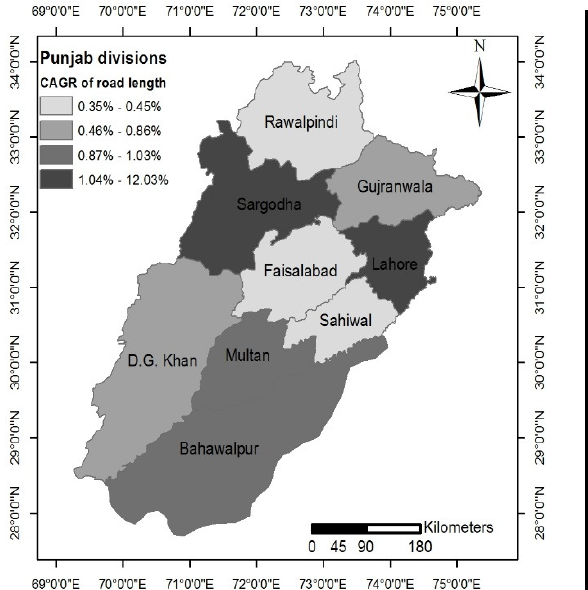
Fig. 10: Percentage Distribution of CAGR of Road Length